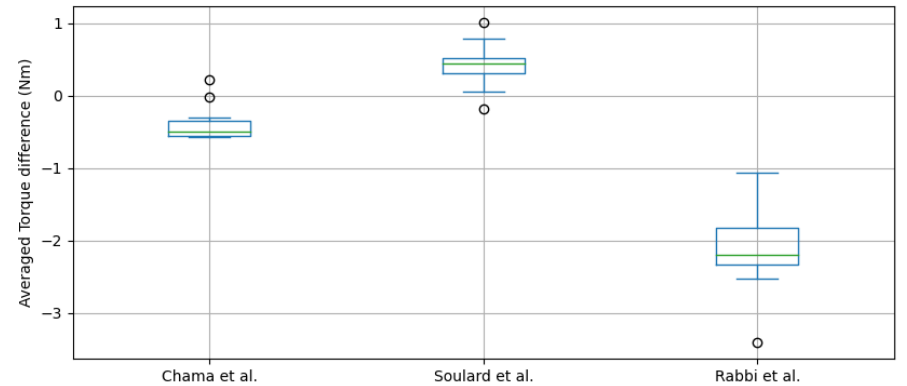
Figure 10. Box plot of average torque difference of various (Rabbi et al. [8], Chama et al. [9], Soulard et al. [19]) analytical T c equations from target T c for the design set.